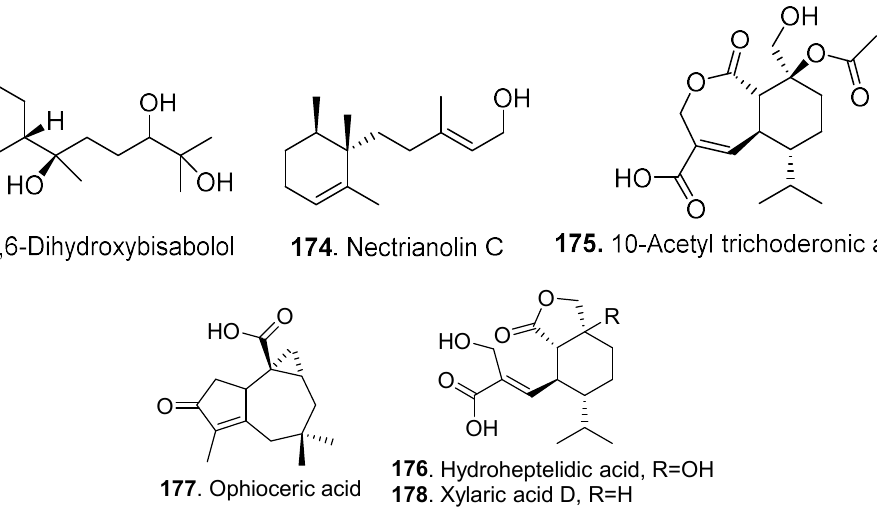
Figure 10. Sesquiterpenoids isolated from Clonostachys fungi.